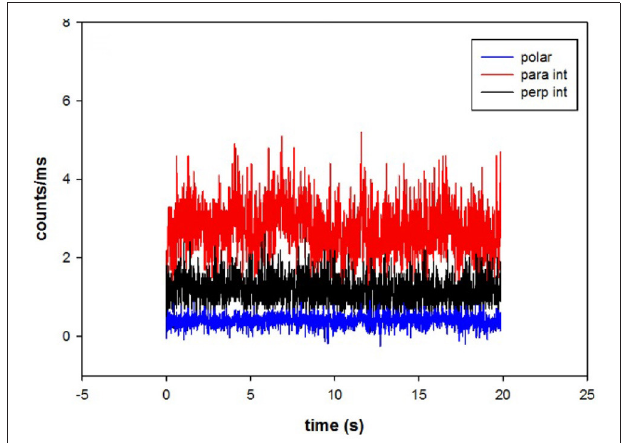
FIGURE 3 | The time course of intensities of fluorescent light from myosin. Fluorescent intensities are polarized parallel (red) and perpendicular (black) with respect to the axis of the myocyte. Polarization of fluorescence is shown in blue. The average polarization of fluorescence was 0.400 ± 0.158. The signal from the OV of a left ventricle in the presence of